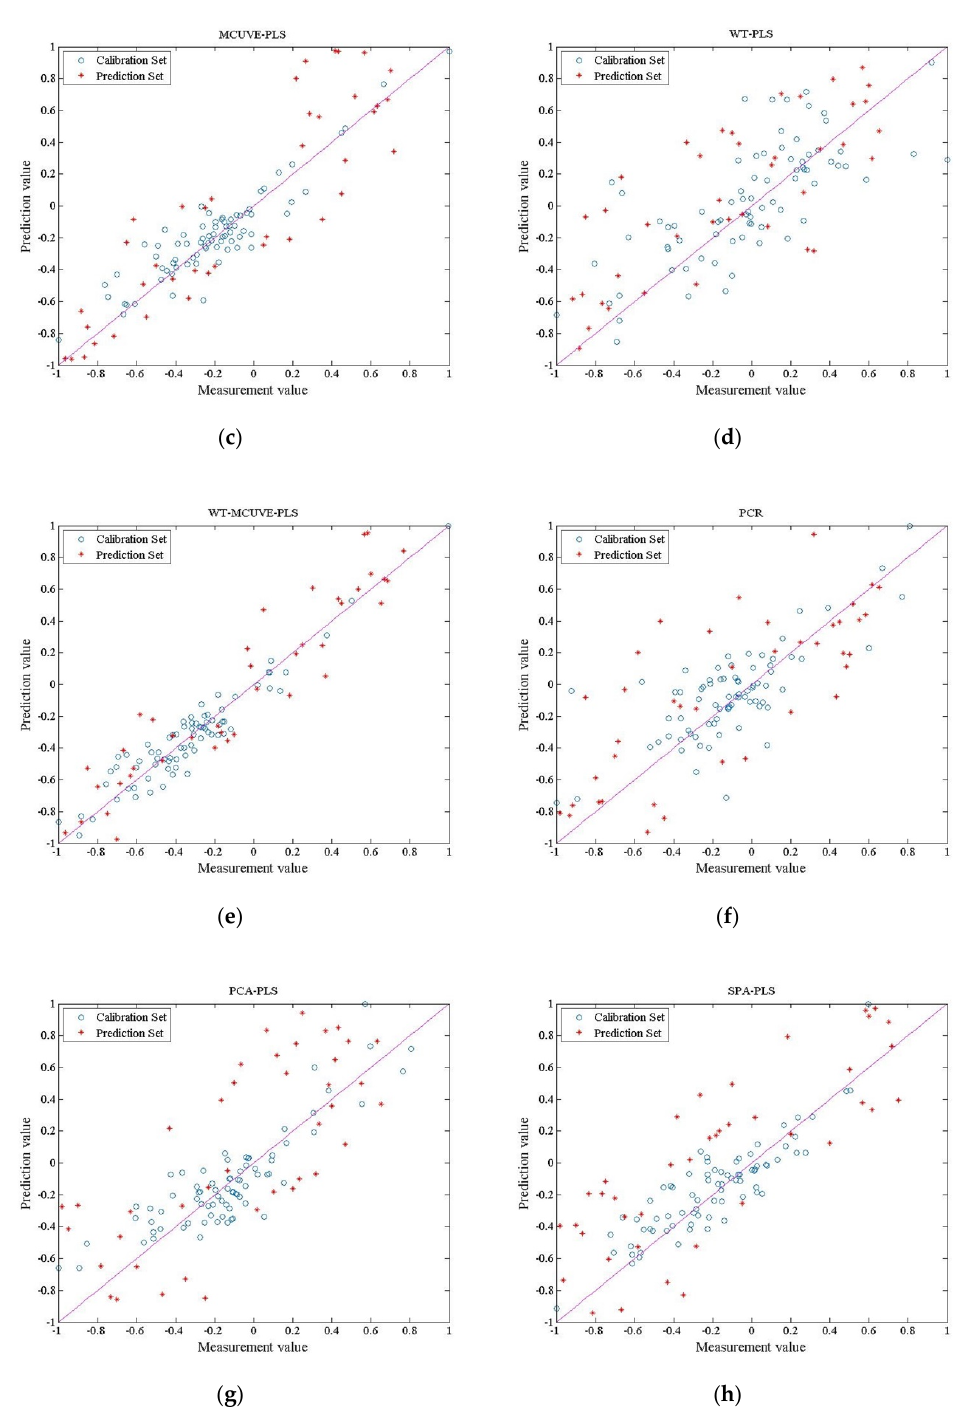
Figure 7. Correlation plot for the prediction of lipid content using PLS, UVE–PLS, MCUVE–PLS, WT–PLS, WT–MCUVE–PLS, principal component regression (PCR), PCA–PLS, and successive projections algorithm (SPA)–PLS models based on NIR spectra, ( a ) The visualization output of PLS, ( b ) The visualization output of UVE–PLS, ( c ) The visualization output of MCUVE–PLS, ( d ) The visualization output of WT–PLS, ( e ) The visualization output of WT–MCUVE–PLS, ( f ) The visualization output of PCR, ( g ) The visualization output of PCA–PLS, ( h ) The visualization output of